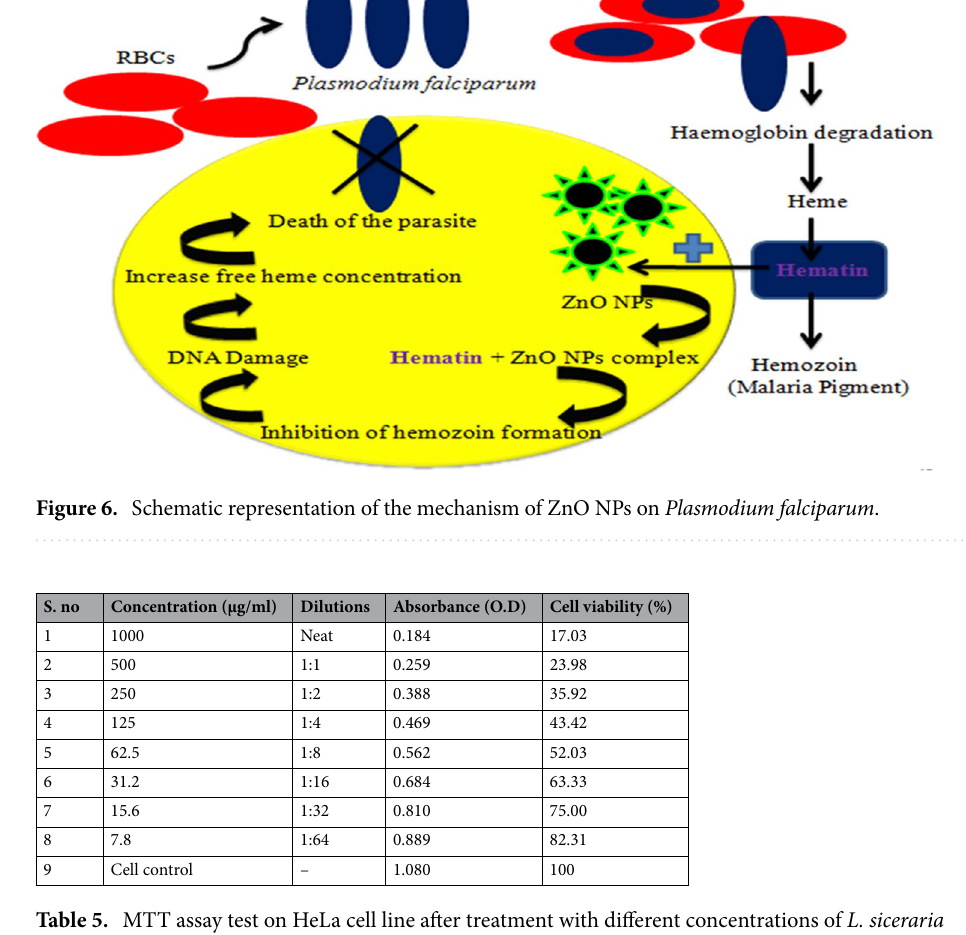
Table 5. MTT assay test on HeLa cell line after treatment with different concentrations of L. siceraria mediated ZnO NPs.